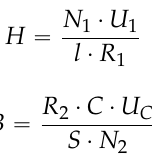
Figure 1. Diagram of dynamic hysteresis loop measurement.